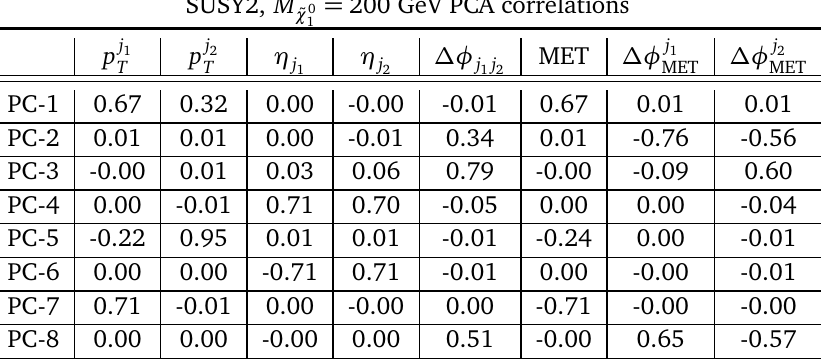
Table B4: PCA original features to principal component correlations for the SUSY2 case (rounded to 2